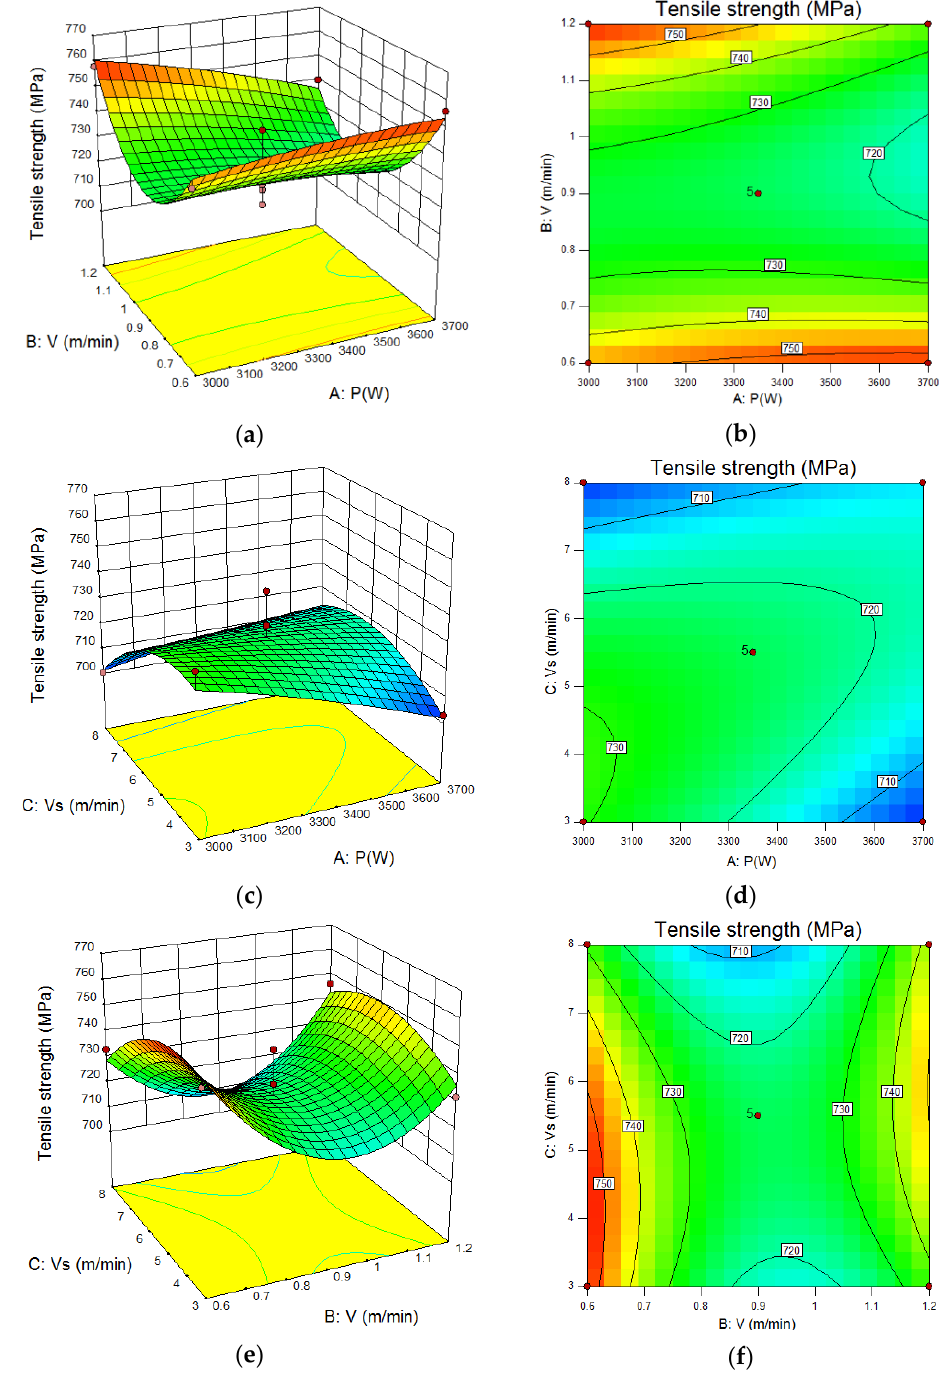
Figure 10. Contour map and isoline diagram of the effect of welding process parameters on tensile strength ( a ) Contour map of P-V, ( b ) Isoline diagram of P-V, ( c ) Contour map of P-Vs, ( d ) Isoline diagram of P-Vs, ( e ) Contour map of V-Vs, ( f ) Isoline diagram of V-Vs.